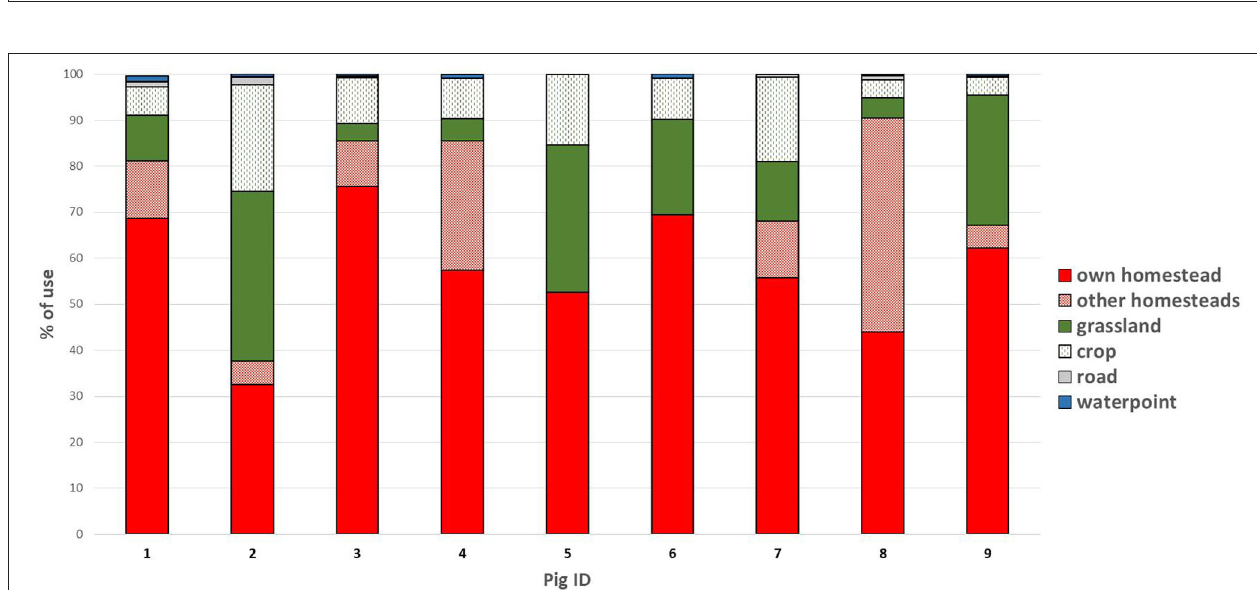
FIGURE 5 | Use of the 6 habitats of interest by the 9 monitored domestic pigs, expressed in proportion of the total recorded locations.